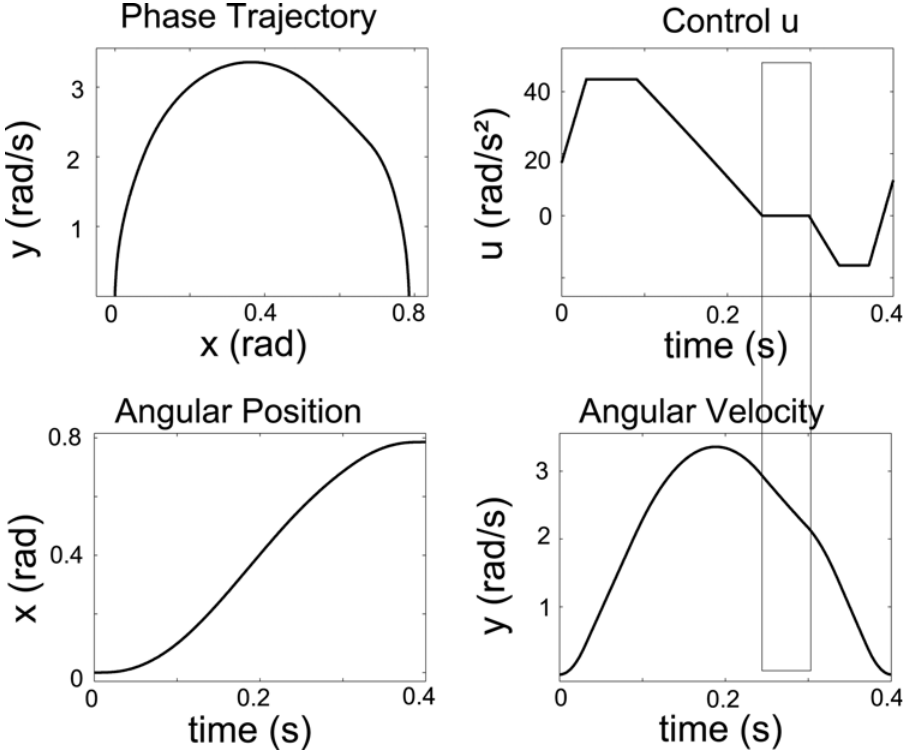
Figure 1. Results for a simulated 1-dof upward movement, with gradient constraints on the torque. The theoretical phase of inactivation of the muscles is shown (rectangular frame). Note that the time to peak velocity (TPV) is 0.47 in this case. It would be equal to 0.53 for the corresponding downward movement, according to experimental findings showing the same directional asymmetries. The signal u corresponds to the ratio between the net torque acting at shoulder joint and the arm’s moment of inertia. Simulated 2-dof vertical arm movements are also depicted in Figure 2. Partial inactivation, illustrating the Inactivation Princi- ple, occurs at each joint separately (elbow and shoulder).